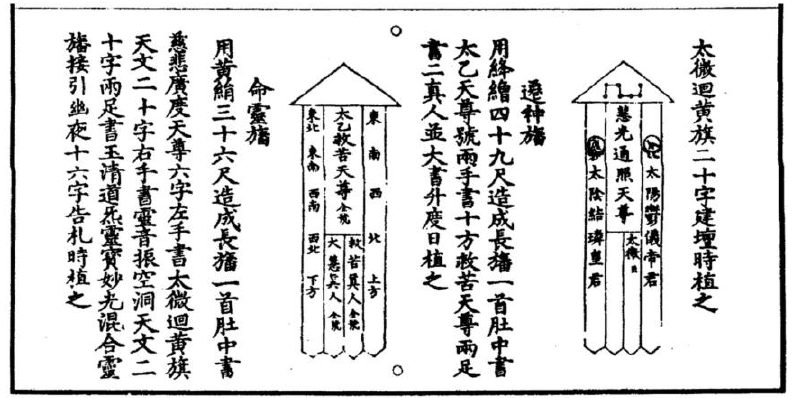
Figure 7. Daoist “ Spirit-Moving Banner ” (middle part), Golden Book of Salvation According to the Nu- Figure 7. Daoist “Spirit‑Moving Banner” (middle part), Golden Book of Salvation According to the Nu‑ minous Treasure Tradition (Lingbao lingjiao jidu jinshu ), DZ 466, Daozang 8:577c. minous Treasure Tradition (Lingbao lingjiao jidu jinshu ), DZ 466, Daozang